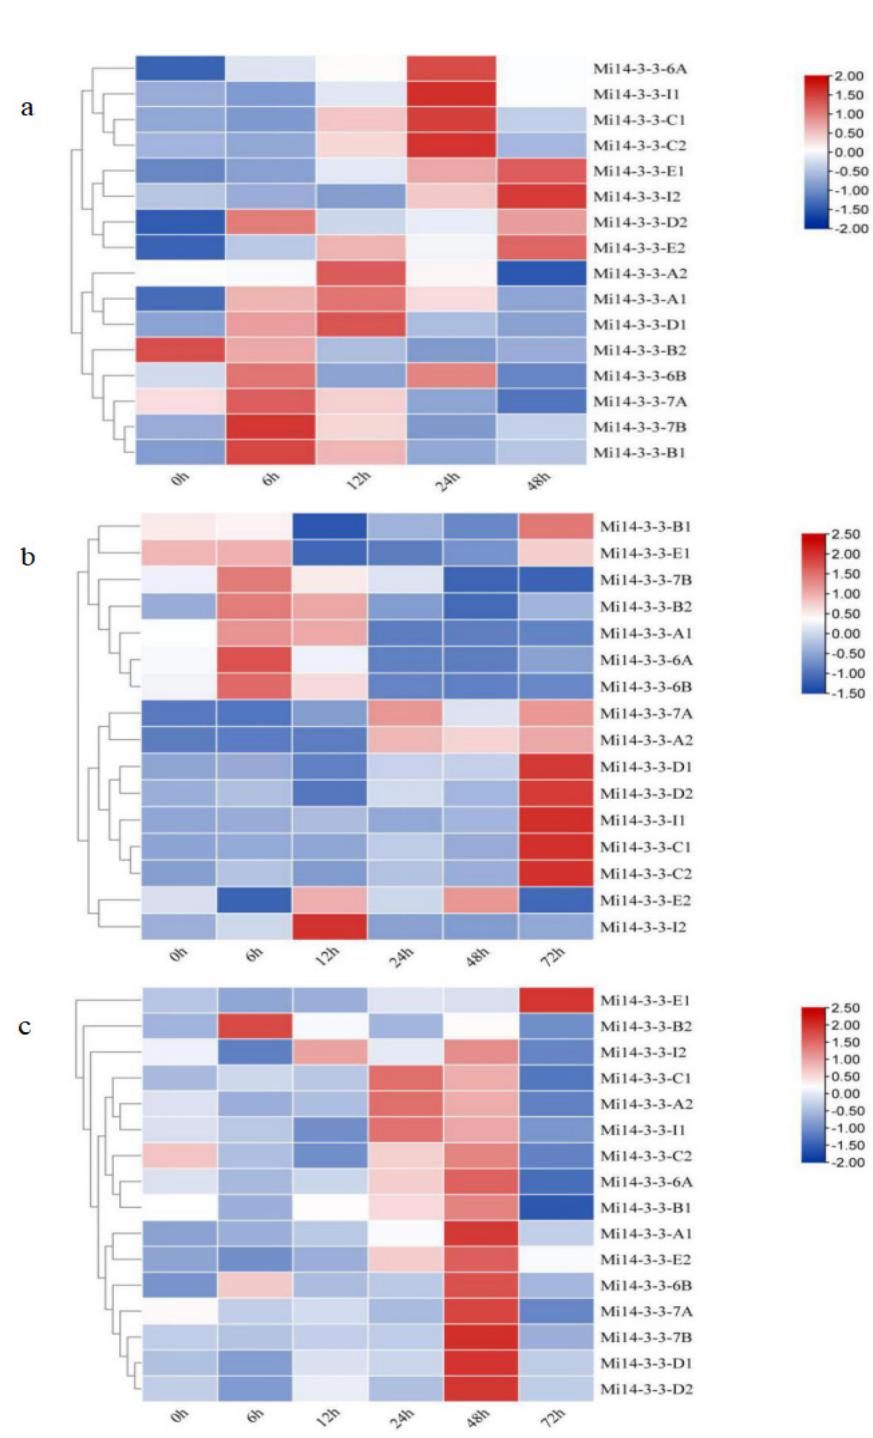
Figure 9. Expression profiles of Mi14-3-3s in response to different stresses. ( A ) Cold stress (2 ◦ C). ( B ) Treatment with 30% PEG6000, simulating drought stress. ( C ). NaCl (300 mM) treatment. The relative expression was normalized to that of the ACTIN gene, used as a reference, via the 2 − ∆∆ Ct method. The heatmaps were generated based on the log2 (treatment expression/control expression) values with HemI. The colour gradient (red/white/blue) indicates the gene expression level (from high to low). The values indicate the means of three biological